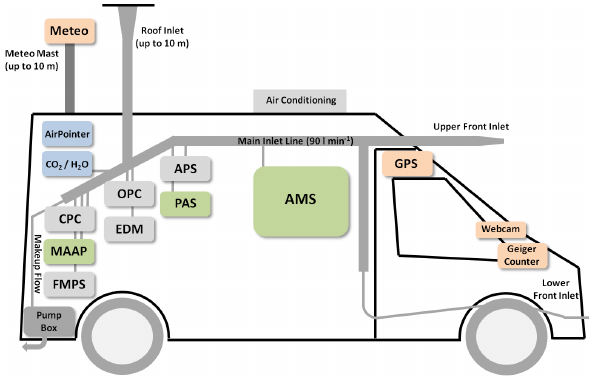
Fig. 3. Schematic overview of the MoLa aerosol inlet system and of the locations of the various instruments within the vehicle (grey: instruments for physical aerosol parameters; green: instruments for aerosol composition; blue: gas-phase instruments; red: other instru-